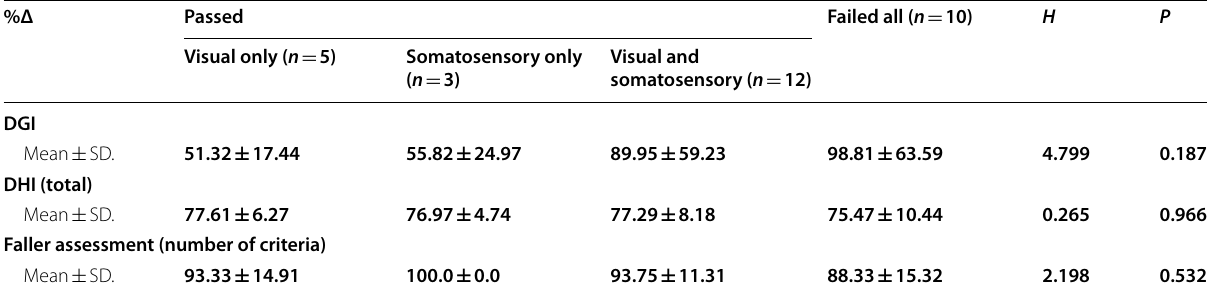
H H for Kruskal Wallis test, p p value for comparing between the different groups, SD standard deviation, %Δ % of change between pre- and post-vestibular rehabilitation